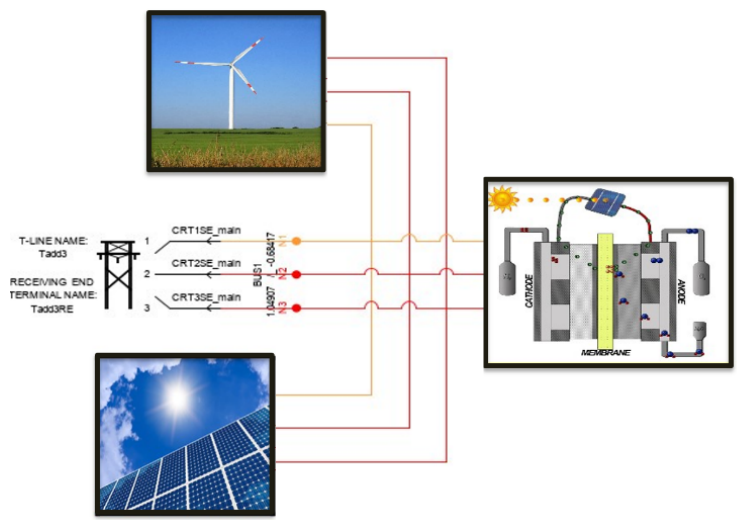
Figure 4. Screenshot of the RSCAD implementation of a renewable energy hub, including a solar farm and a PEM electrolyzer, with a theoretical expansion to include a Type-4 wind turbine [13].